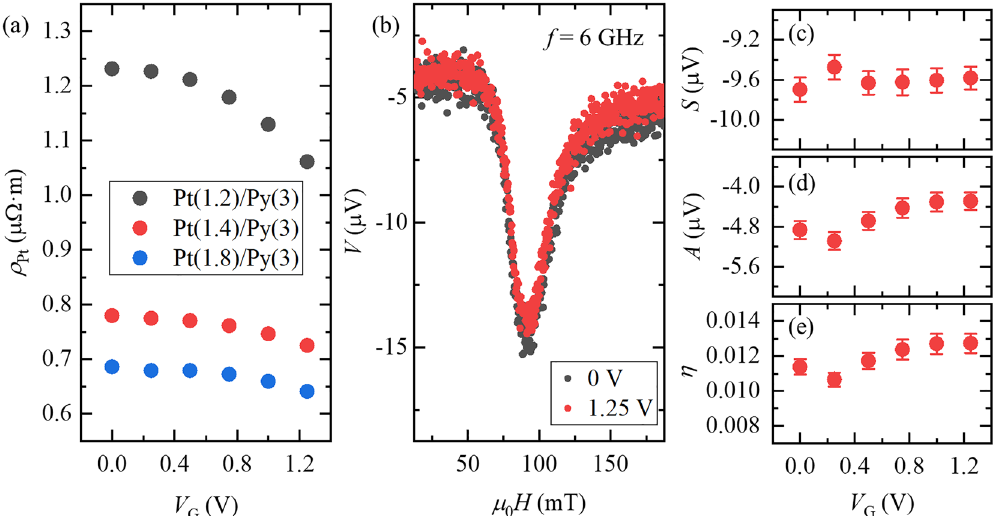
Figure 2. Gate dependence of the resistivity and ST-FMR signals of ultrathin Pt on Py. ( a ) Gate voltage V G dependences of Pt resistivity ρ Pt in three devices with different Pt thicknesses are displayed. All values in parentheses in the caption are in nm. The resistivity of Pt becomes greater as the thickness of Pt becomes smaller. The Pt resistivity decreased as a positive gate voltage was applied, which is due to charge accumulation by gating. ( b ) ST-FMR spectra of the Pt(1.2 nm)/Py(3 nm) device at gate voltages of 0 V (black closed circles) and 1.25 V (red closed circles). The frequency, f , was set to 6 GHz. Gate voltage dependence of ( c ) the symmetric component, S , ( d ) the anti-symmetric component, A and ( e ) spin-conversion efficiency, η